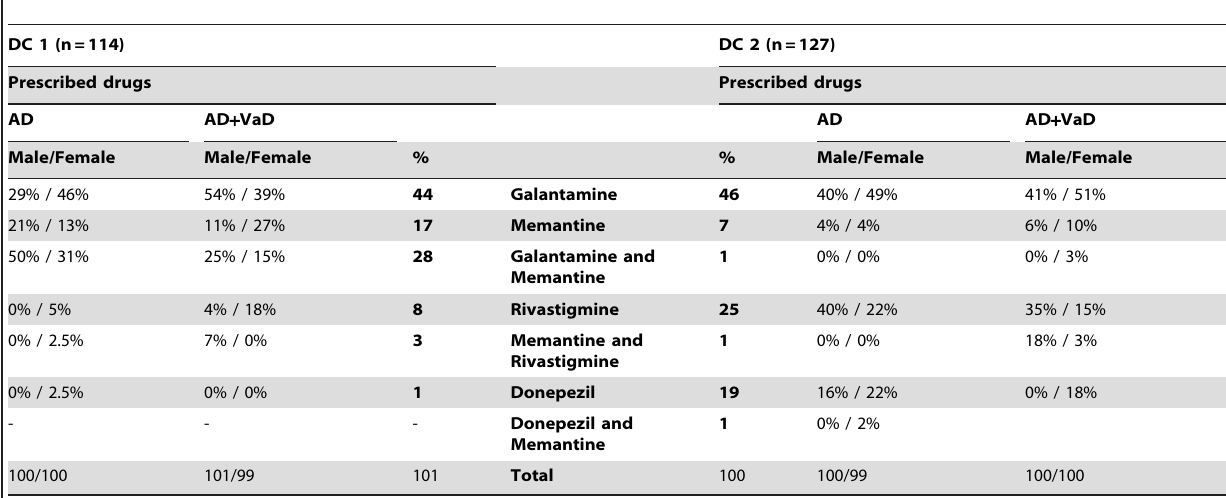
Table 3. Prescription of dementia drugs from dementia clinics to patients according to specific diagnosis and gender.